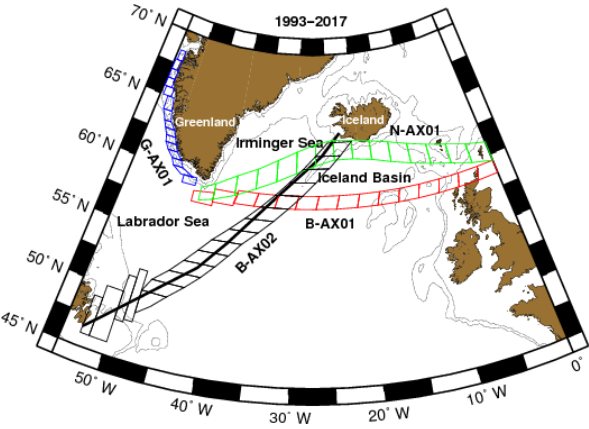
Figure 1. Map of the bins along B-AX01 (red), B-AX02 (black), G-AX01 (blue), and N-AX01 (green). A typical example of a ship track is shown along